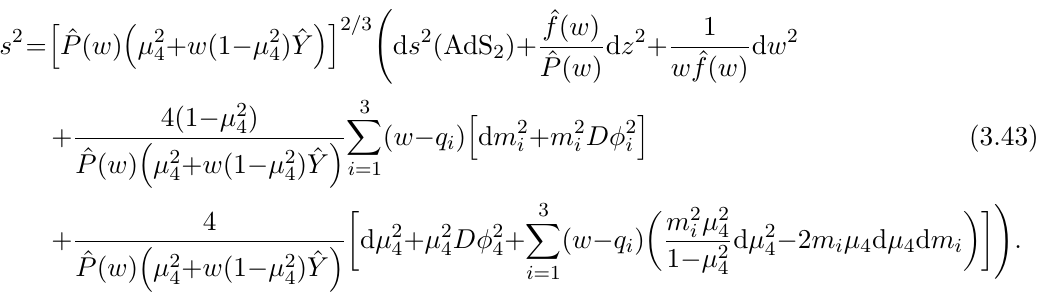
Figure 4 . A schematic plot of the rectangle over which the S 5 × S 1 indicates that the φ 4 circle pinches smoothly to R 2 . Along the green edge the metric is smooth, but has a singularity consistent with a smeared M2 brane at the intersection with the blue line. At the opposite corner sits a monopole leading to a R 8 / Z k